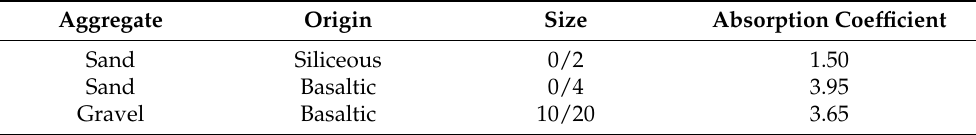
Table 5. Origin, size, and absorption coefficient of the aggregates.